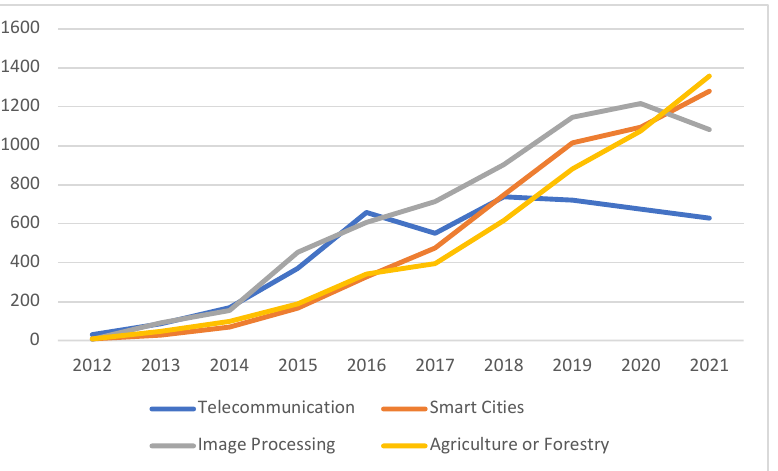
Figure 3. The number of research publications per year for the Big Data application areas of telecom- munication, smart cities, image processing and agriculture or